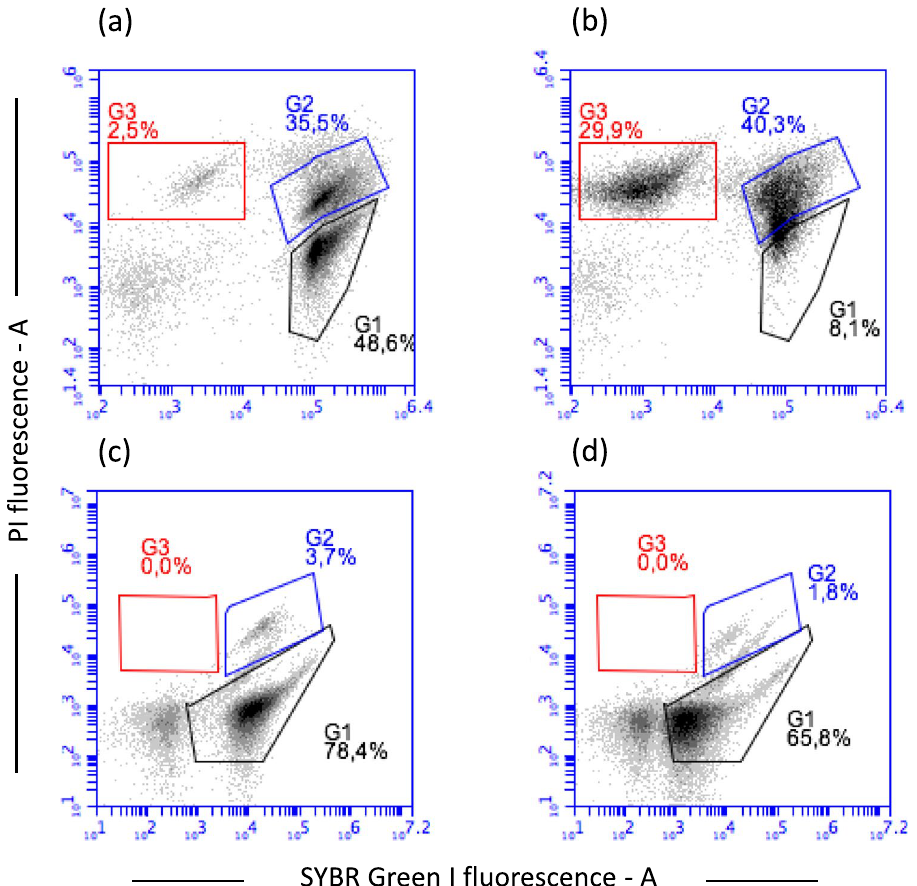
Figure 4. Membrane damage in P. aeruginosa ATCC 10145 and S. thermophilus DSM 20617 T exposed to surfactin. Flow cytometry density diagrams show the SYBR Green I vs PI fluorescence of cells exposed to promysalin or chlorhexidine or both the molecules. Viable cells are gated in G1, viable cells with slightly damaged cell membrane are gated in G2. Dead cells with damaged membrane are gated in G3. The transition of cell population from gate G1 to gate G3 is related to the entity of cell membrane damage. ( a ) S. thermophilus incubated 60 min at 37 °C in presence of DMSO. ( b ) S. thermophilus incubated 60 min at 37 °C in presence of surfactin (200 µ g/ml). ( C ) P. aeruginosa cells incubated 60 min at 37 °C in presence of DMSO. ( d ) P. aeruginosa cells incubated 60 min at 37 °C in presence of surfactin (200 µ g/ml). DMSO was added to cell suspension in the same amount which was present in the surfactin